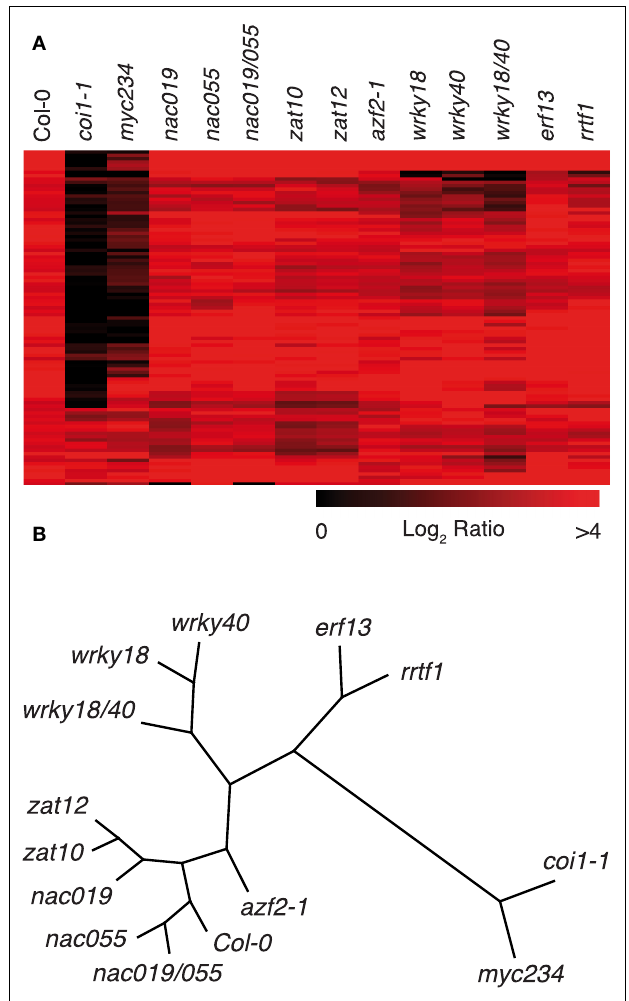
FIGURE 4 |Whole-genome expression profile of transcription factor mutants. (A) Heat map clustering the 100 most highly induced genes in Col-0 plants after 8days of insect feeding and their respective expression in mutant plants. Heat map was created with MultiExperimentViewer 4.8.1. (B) Correspondence analysis of expression profiles including all insect-induced genes (log 2 ratio > 1, P -value < 0.05; n = 874). Clustering and node length calculations were performed with MultiExperimentViewer 4.8.1 and represented as unrooted tree inTreeview 1.6.6